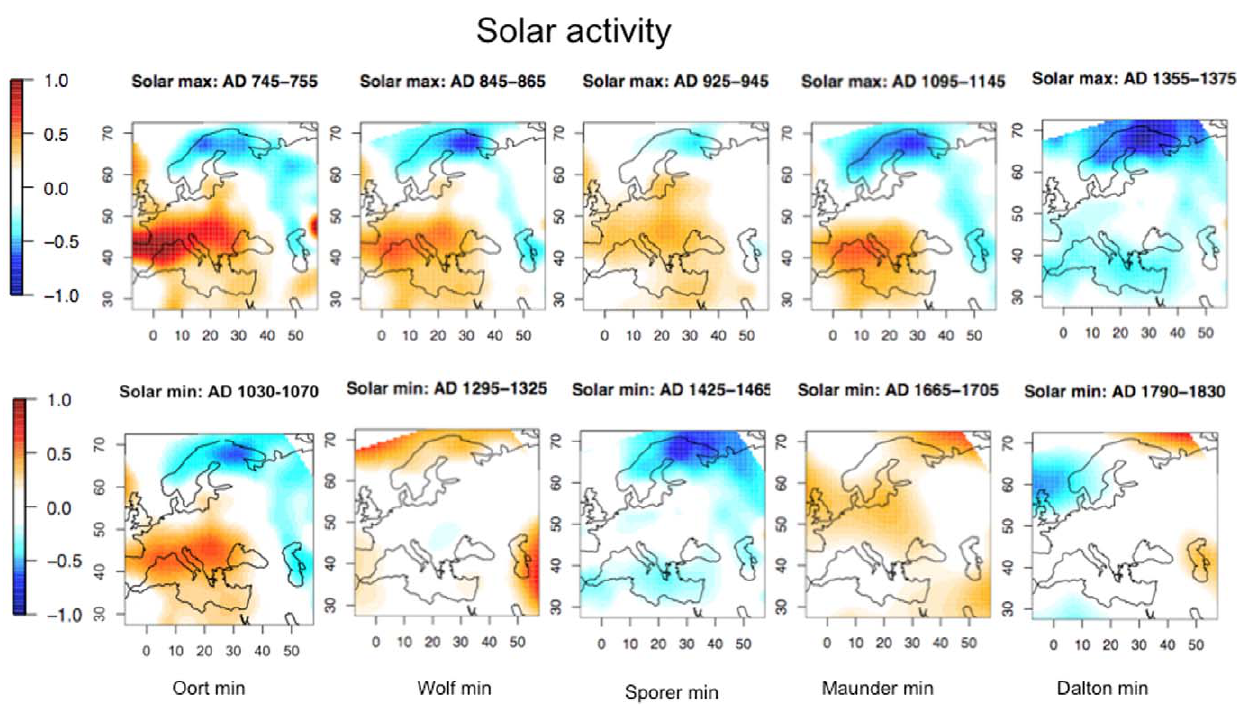
Figure 7. Maps of April to September temperature anomaly reconstructions averaged for time-slices corresponding to high and low solar activity.